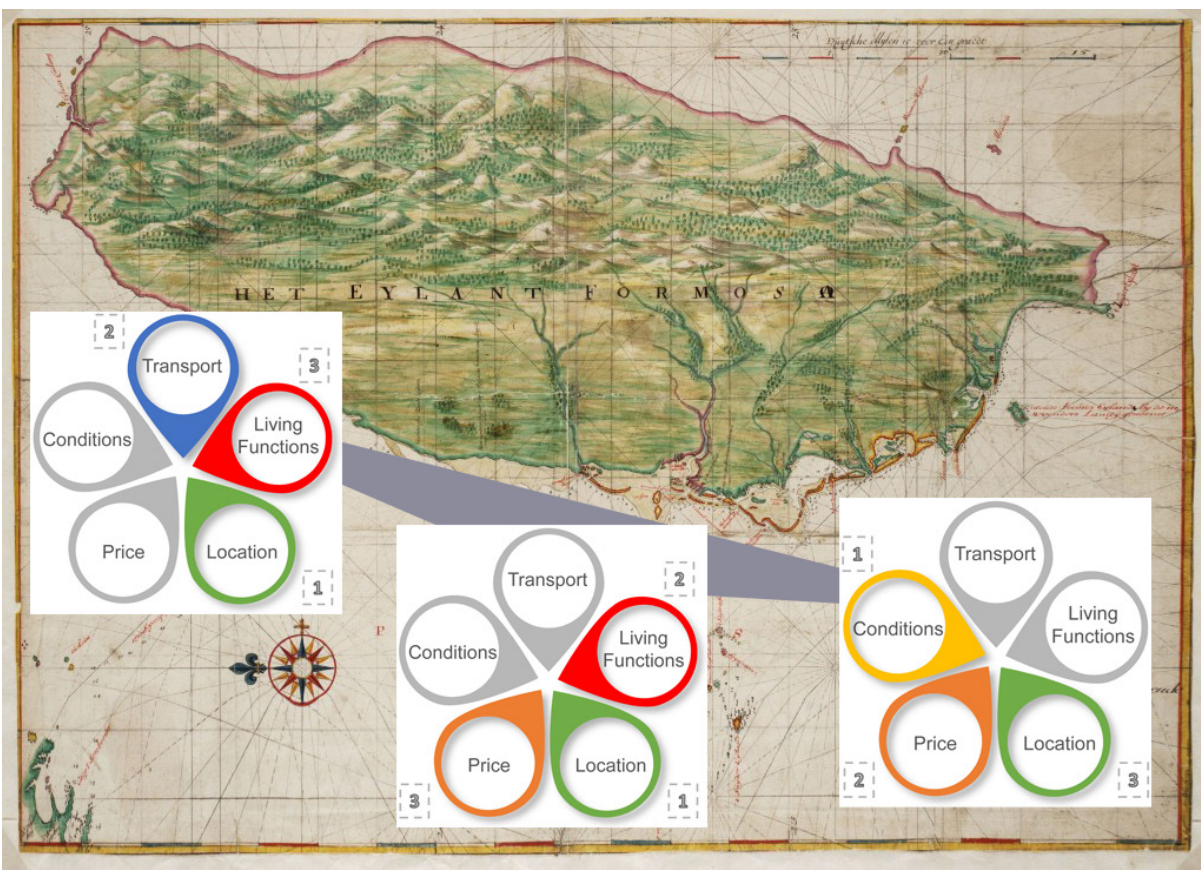
Figure 4. Non-paradigmatic shifts in housing preference structure for a circle of